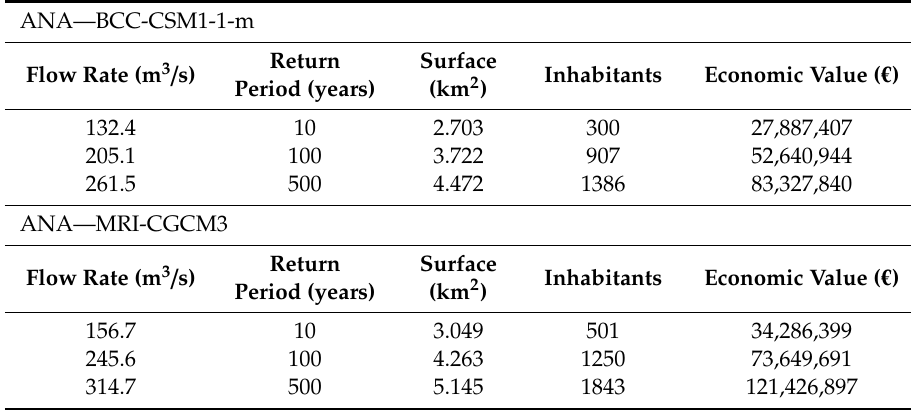
Figure 14. Second Stage (2039–2070)/1st Stage (2007–2038) inhabitants potentially affected ratio trend line in terms of return periods. ( a ) ANA—BCC-CSM1-1-m; ( b ) ANA—MRI-CGCM3. Flooded surface, inhabitants potentially affected and flood economic damage value can be calculated in absolute terms and are shown in Table 4 for ES091_HIJ_01_02_04_05_06. Table 4. Absolute terms for the flow rate, flood surface, inhabitants potentially a ff ected and flood damage’s economic value for selected climate change projections 1